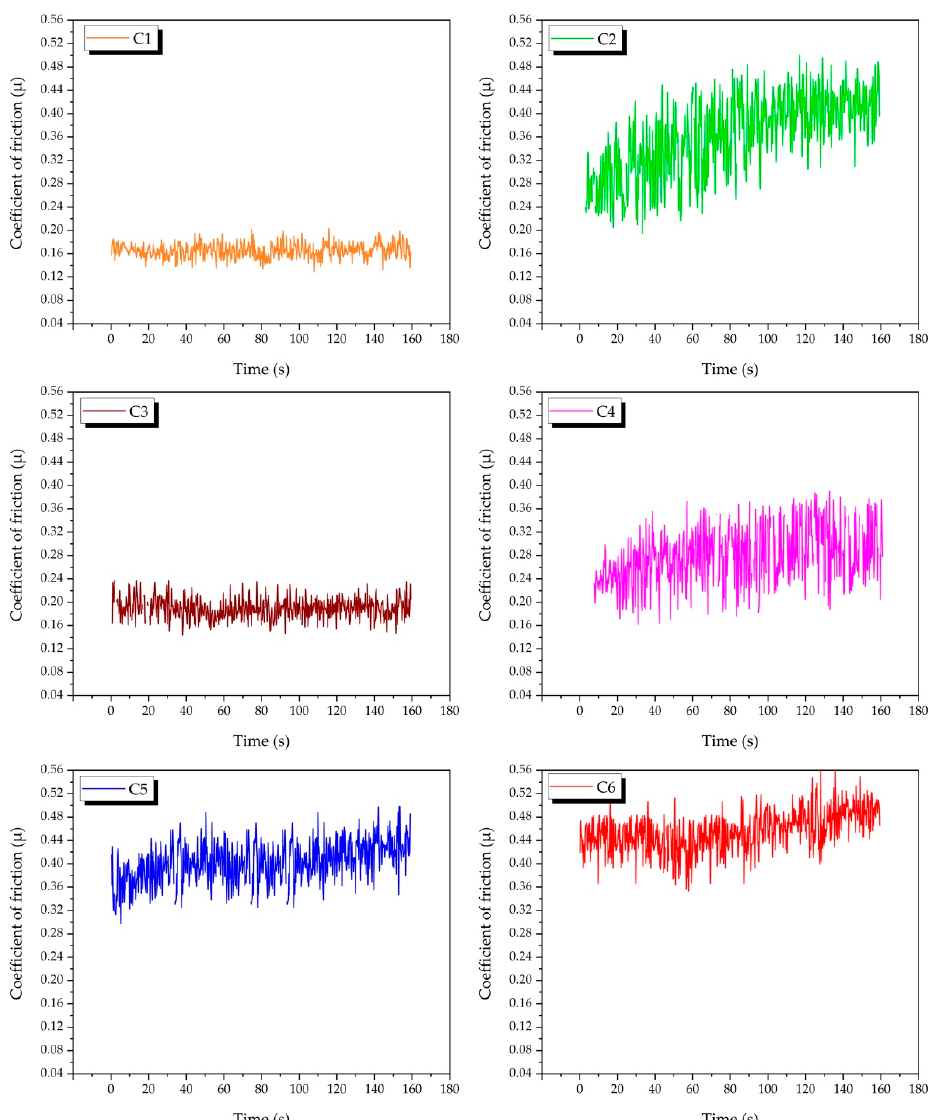
Figure 13. Time-dependent variation of the coefficient of friction of composite samples.